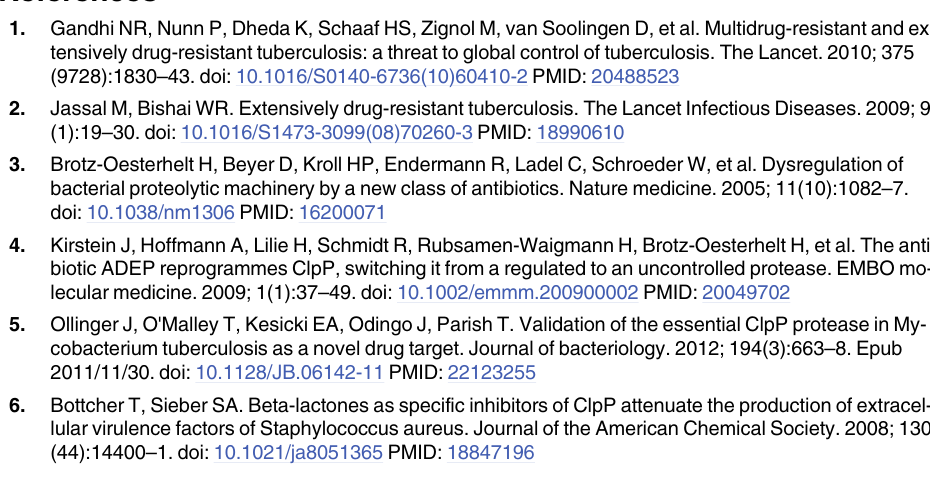
conserved proline with a yellow box. The annotation of the N-loop and pore residues is based on the Mtb ClpP2 structure (4U0G.pdb). S8 Fig. The Mtb ClpP1P1 and ClpP1P2 show differences in their ring-ring interaction sur- face areas. Interaction residues of ClpP1P1 (2CE3.pdb, left side) and ClpP1P2 (4U0G.pdb, right side) were determined and depicted using the COCOMAPS web application with stan- dard settings [50]. The individual rings are colored light violet and light pink in cartoon repre- sentation, while the respective interaction residues are colored in dark violet and dark pink and are additionally shown in stick representation. S9 Fig. Hydrophobic interactions in the ClpP1P1 and ClpP1P2 ring-ring interfaces. The in- teraction surface areas of ClpP1 (upper left) and ClpP2 (upper right) of the active/extended ClpP1P2 structure (4U0G.pdb) and of one ClpP1 ring (lower left) of the inactive/compressed ClpP1P1 structure (2CE3.pdb). The rings are shown from the interface side and the residues involved in the interaction, as determined by the COCOMAPS web application with standard settings [50] are rimmed with a yellow dotted line. Amino acids are colored according to their hydrophobicity using the Eisenberg hydrophobicity scale (http://web.expasy.org/protscale/ pscale/Hphob.Eisenberg.html). Red color indicates the most hydrophobic and white color the least hydrophobic